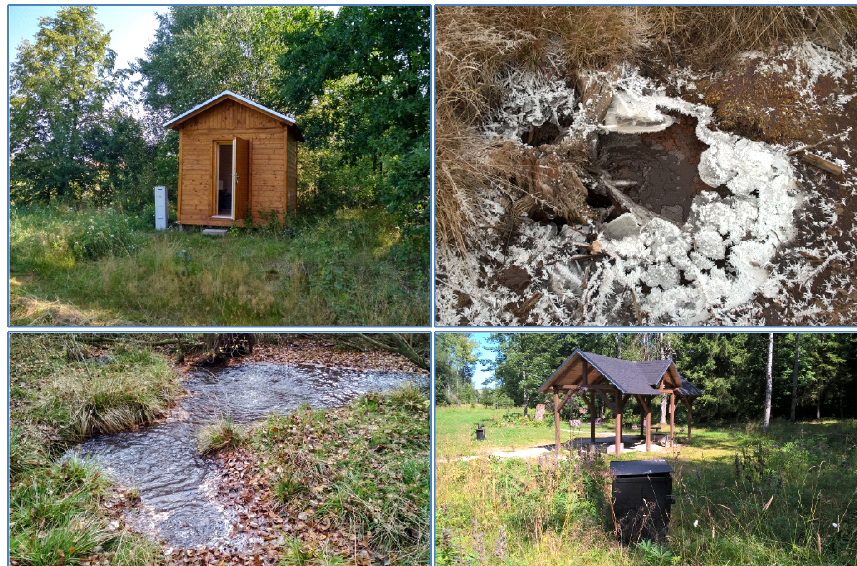
Figure 2. Photos of selected CO 2 monitoring fields – Hartoušov, SOOS, Bublák, and